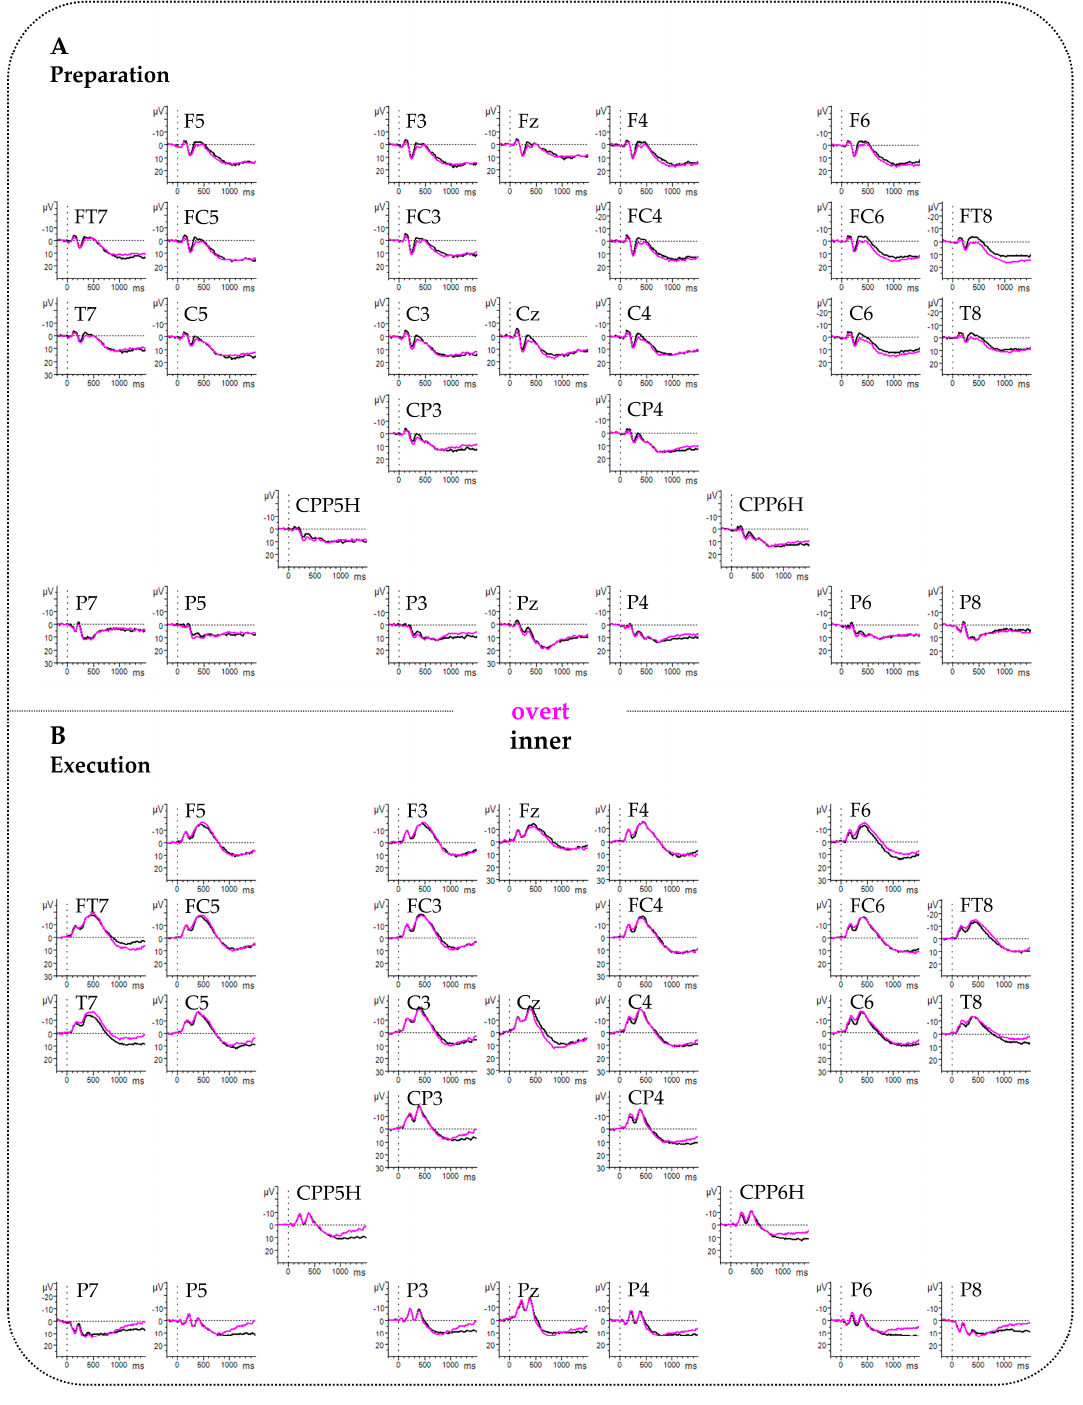
Figure A4. Event-related brain potentials (ERPs). ( A ) Grand averages for the Preparation phase. ( B ) Grand averages for the Execution phase. Negative polarity is plotted upward. The x-axis ranges from − 200 to 1500 ms. No low-pass filter was applied for presentation